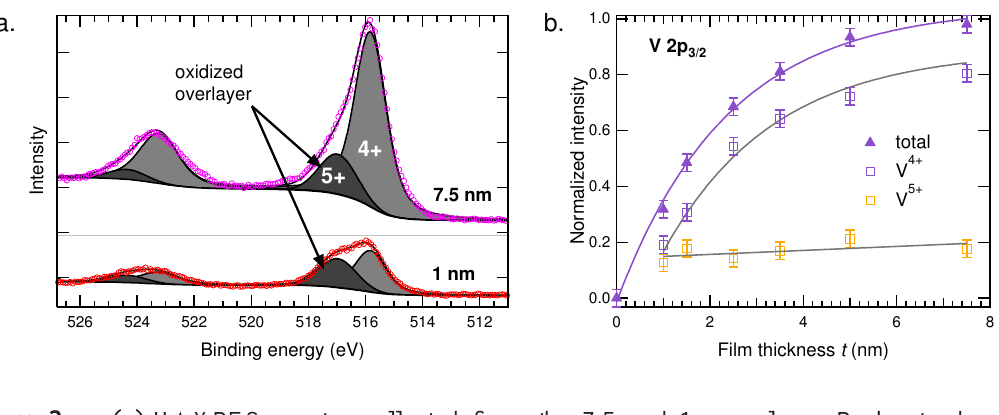
( a ) HAXPES spectra collected from the 7.5 and 1 nm films. Peak fits show the contributions of V 4+ from the film and V 5+ from the overlayer; ( b ) normalized HAXPES signal intensity of the V 2p showing the V 4+ and the V 5+ contributions separately versus film thickness. 3 / 2